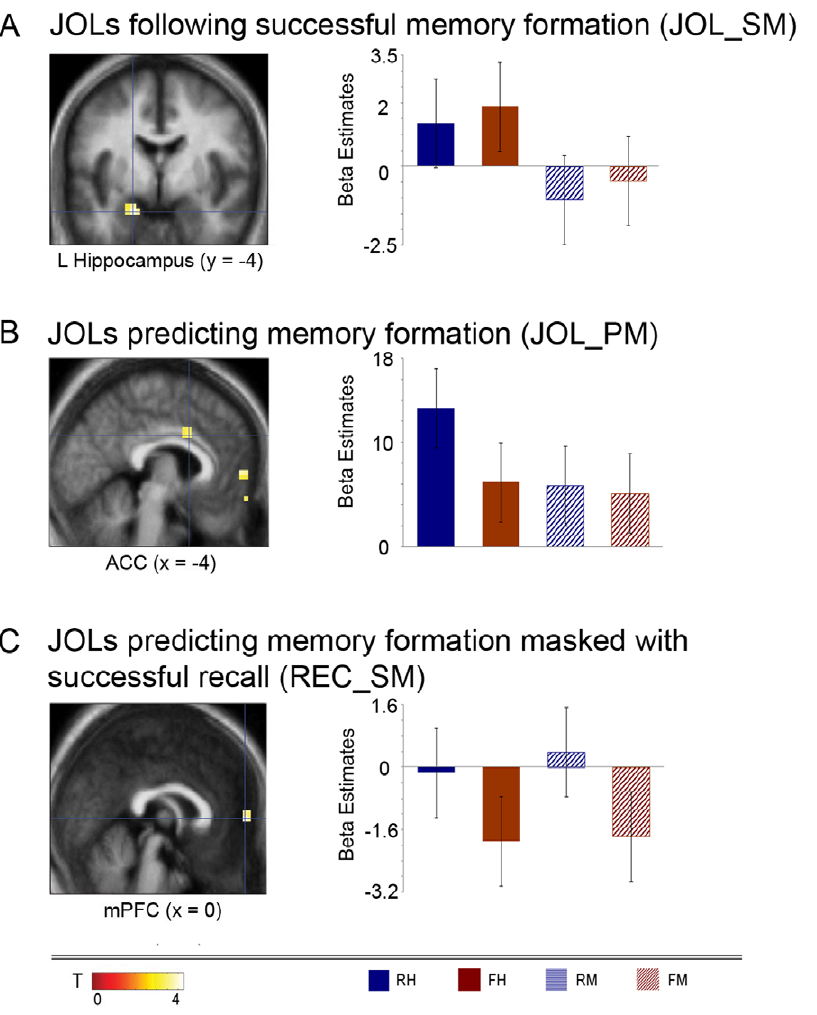
Figure 2. Statistical activation maps, and bar graphs depicting the parameter estimates per condition. Activation maps are overlaid onto the mean anatomical image across participants. Regions of interest (ROIs) defined from (a) JOLs following successful memory formation (JOL_SM) were located in the left MTL; (b) JOLs predicting memory formation were located in the ACC; (c) JOLs predicting memory formation (JOL_PM) masked with successful recall (REC_SM) was located in the mPFC. Coordinates are presented in Table